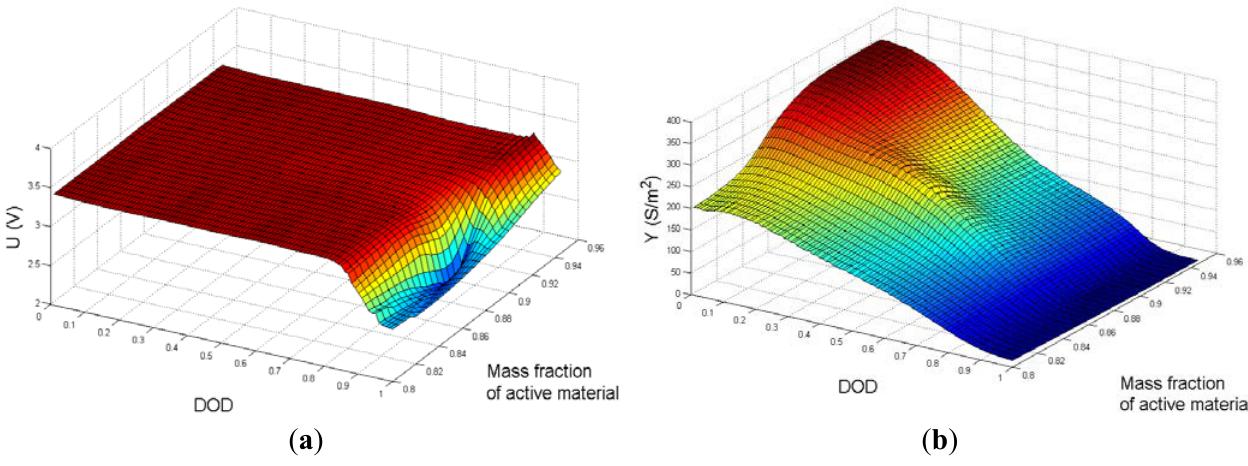
Figure 5. Three-dimensional surface plots of ( a ) U ; and ( b ) Y as functions of DOD and the mass fraction of active material in the